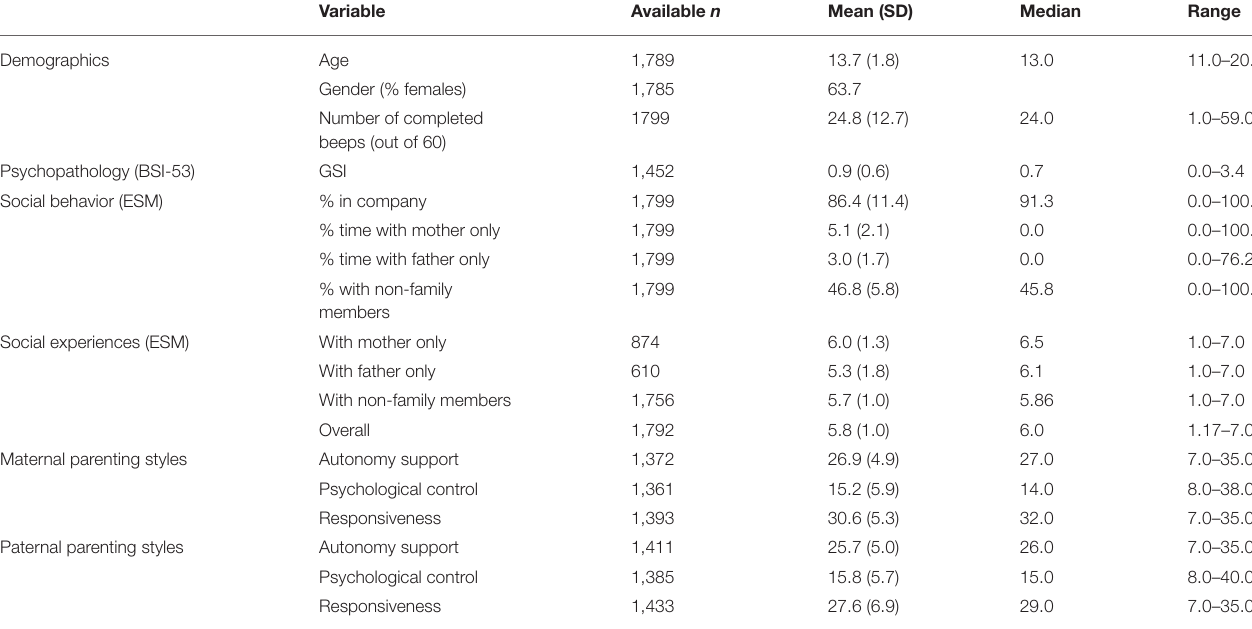
TABLE 1 | Descriptives of included variables.